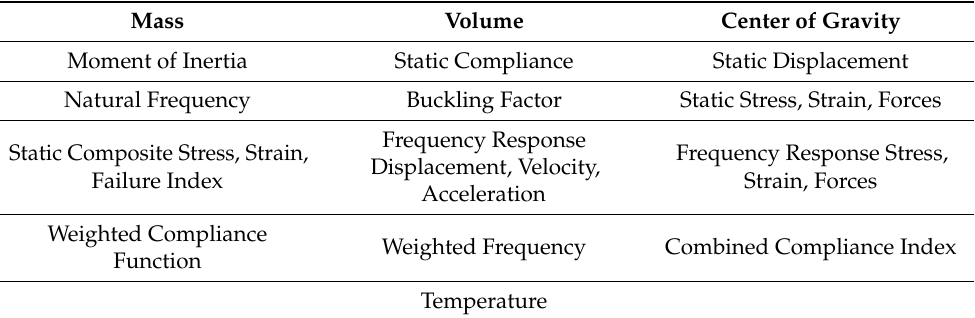
Table 1. Optistruct design goals and functionalities.